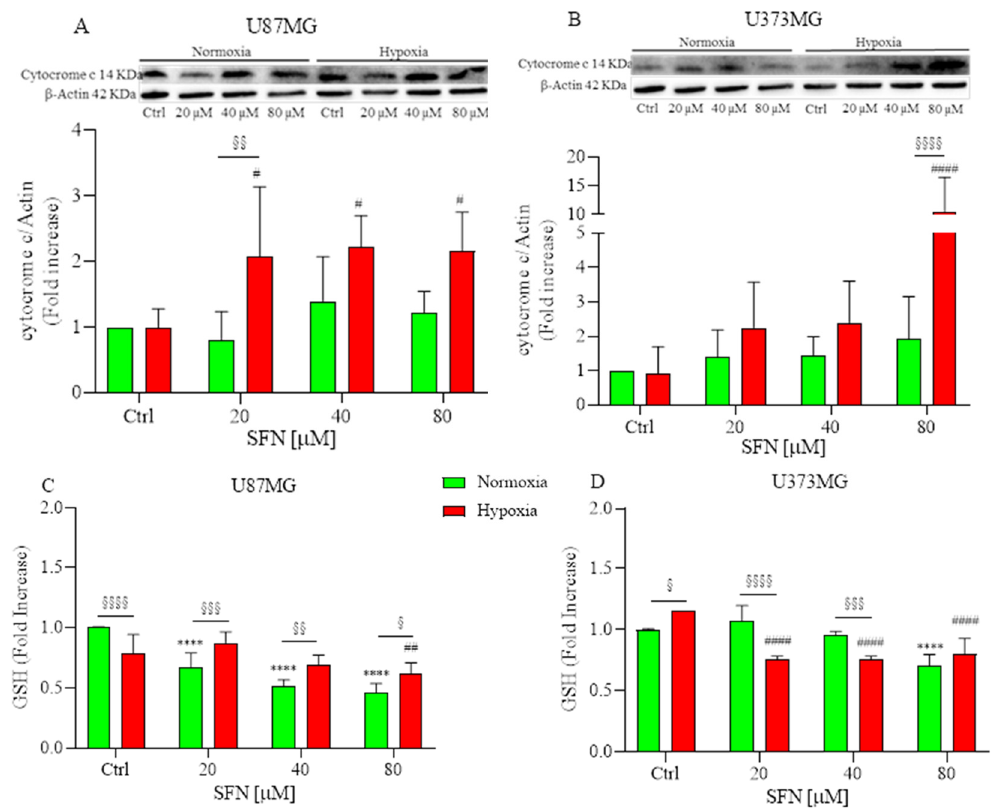
Figure 4. Effects of SFN on mitochondrial ( A , B ) and oxidative status ( C , D ) after 48 h of treatment [20–80 µM] in normoxic (green) or hypoxic (red) conditions. ( A , B ) top: representative images of cytochrome C and β -actin expressions in U87MG ( A ) and in U373MG ( B ) cells. ( A , B ) bottom: quantitative analysis of the Western Blotting results. SFN treatment significantly increased the release of cytochrome c under hypoxia in both cell lines. SFN treatment reduced the levels of GSH in a dose-dependent manner both in normoxic and hypoxic conditions ( C , D ). Data are expressed as fold increases and reported as mean ± SD of three independent experiments (**** p < 0.0001 vs. normoxic Ctrl group; # p < 0.05, ## p < 0.01 and #### p < 0.0001 vs. hypoxic Ctrl group; § p < 0.05, §§ p < 0.01, §§§ p < 0.001 and §§§§ p < 0.0001 vs. the respective normoxic treatment group. Two-way ANOVA, post hoc test Bonferroni).